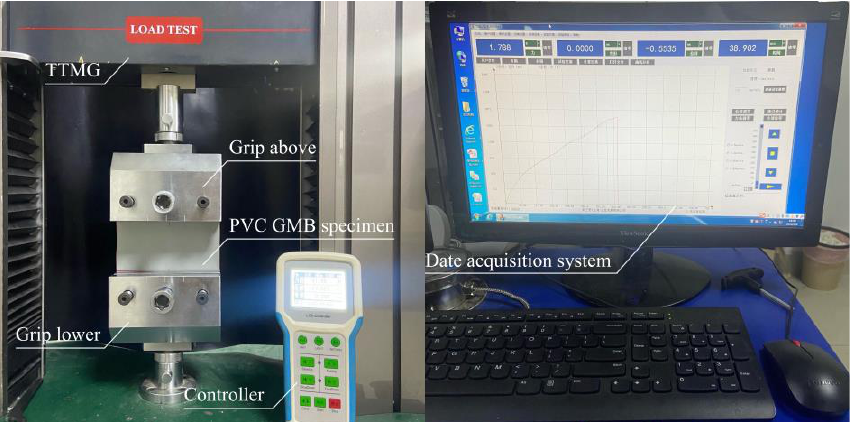
Figure 2. Diagram of stress relaxation test setup.